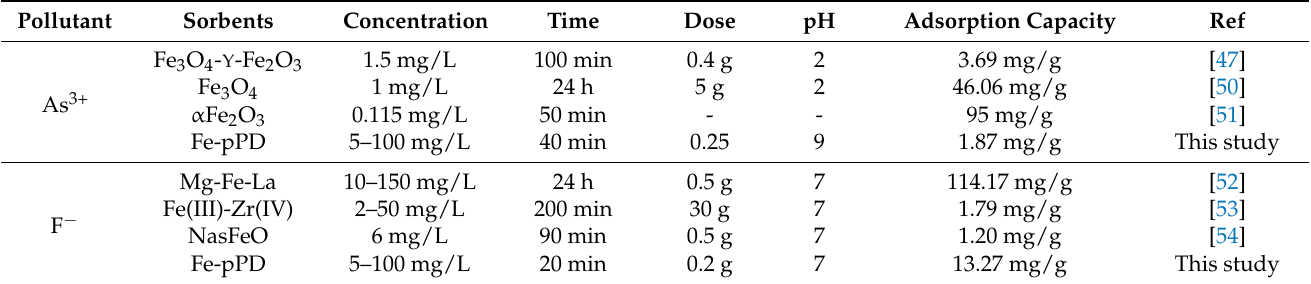
Table 8. Comparison F − and As 3+ removal capacity of Fe-pPD and other iron-based